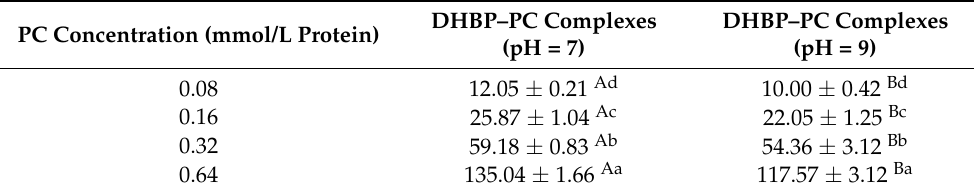
Table 1. Binding equivalent of decolorized highland barley protein (DHBP) and proanthocyanidin (PC) at different pH values (mg/g protein). PC Concentration (mmol/L